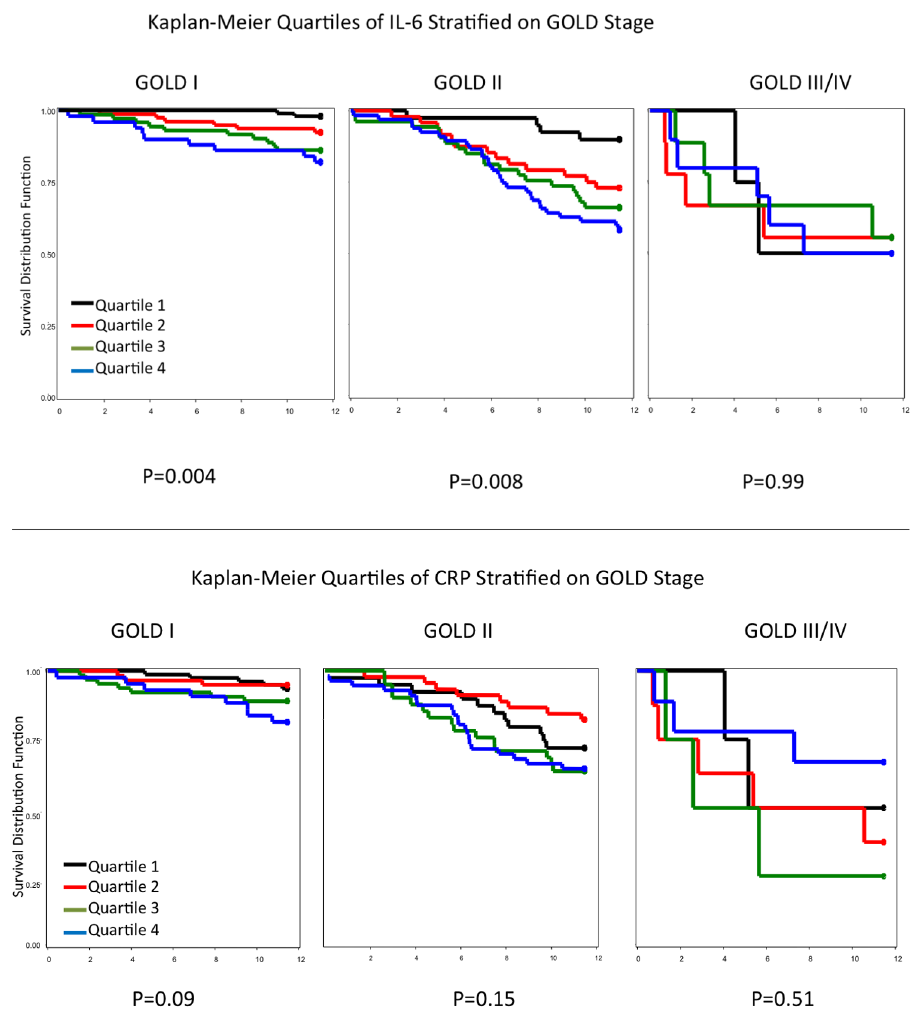
Figure 3. Kaplan-Meier Quartiles of IL-6 Stratified on GOLD Stage.